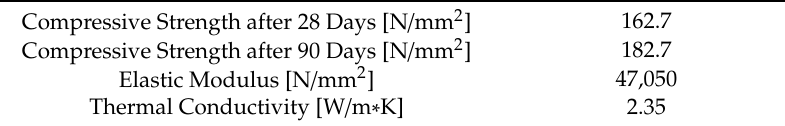
Table 2. Material properties of